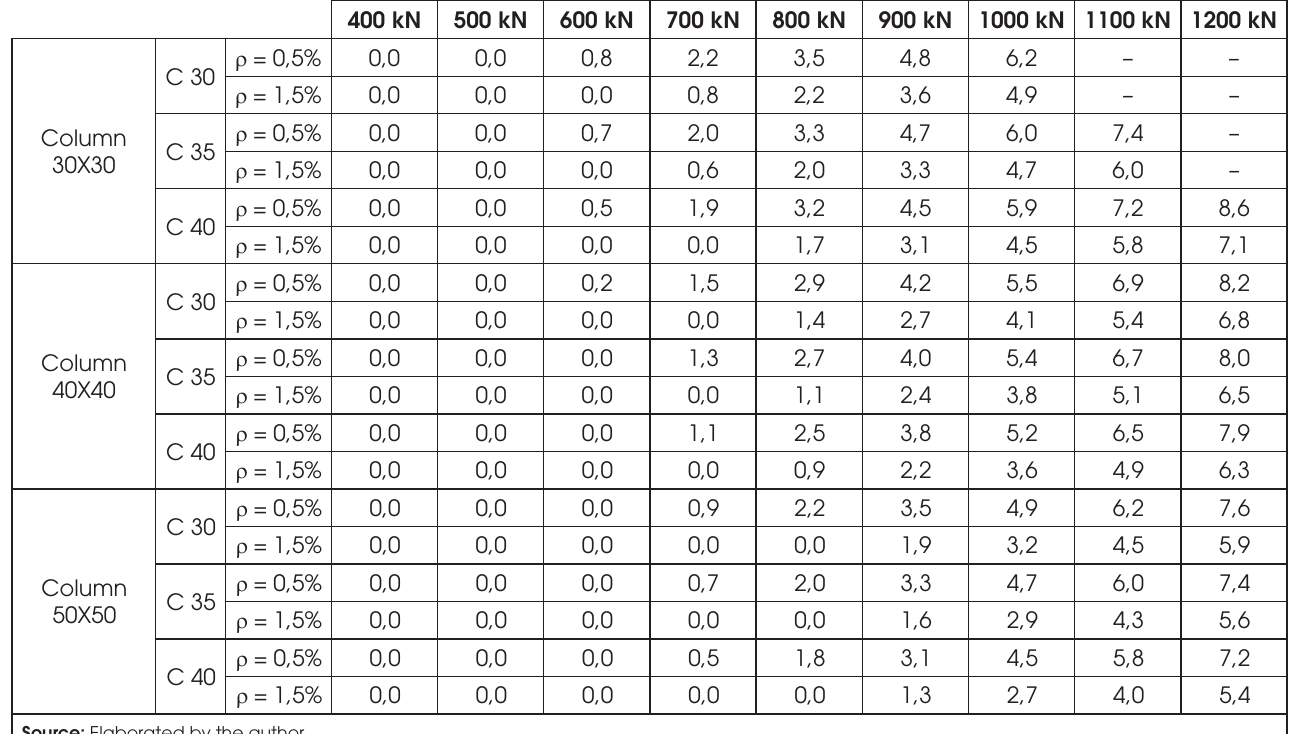
Area of shear reinforcement (cm²) by EC2:2004 (analysis